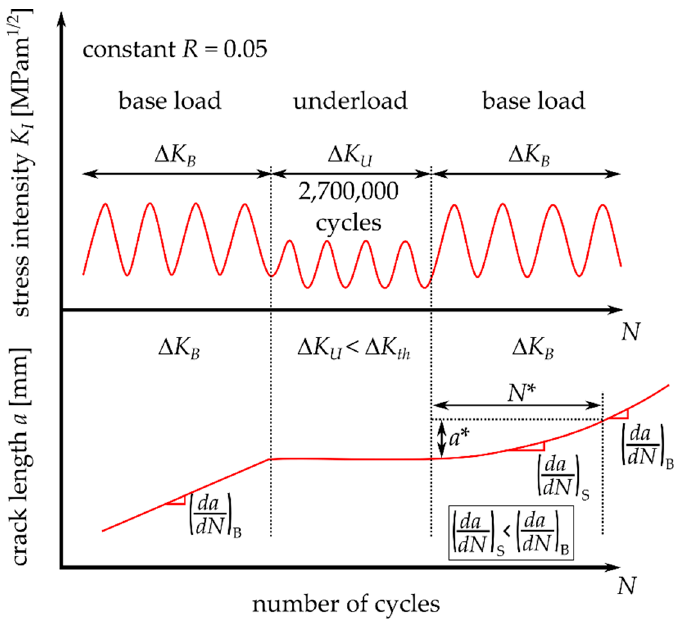
Figure 4. A schematic illustration of the loading sequence used by Suresh and Ritchie in [14]. Adapted with permission from ref. [14]. 1981 Elsevier.